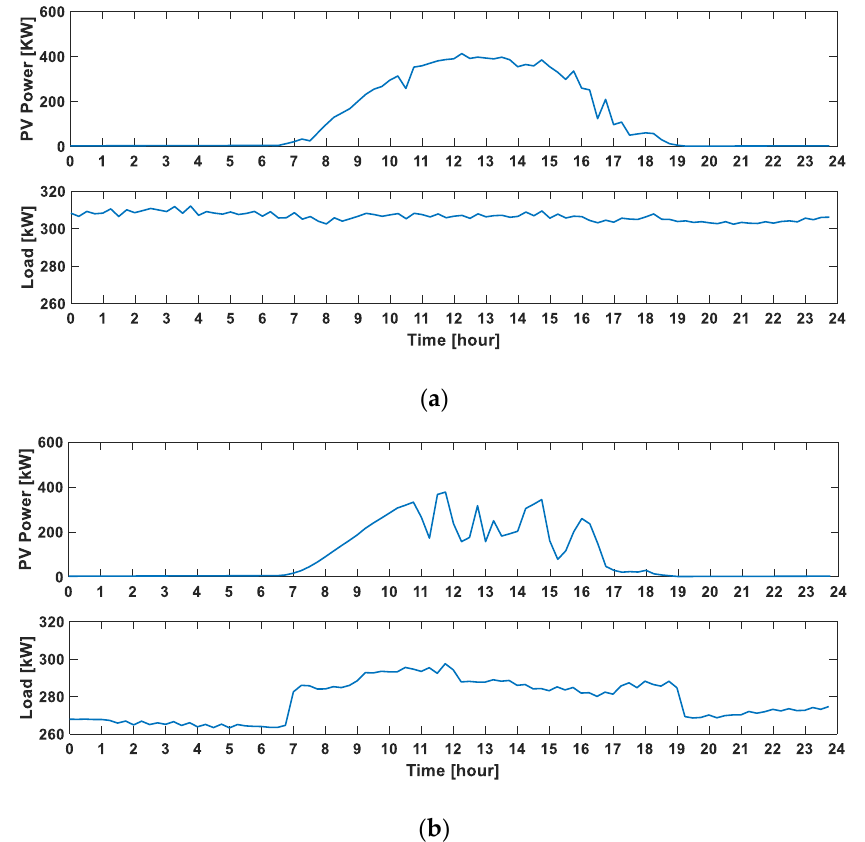
Figure 5. Daily PV generation and pump station load data of NELHA: ( a ) Cases 1 and 2—4 July 2018; and, ( b ) Cases 3 and 4—31 July 2018.